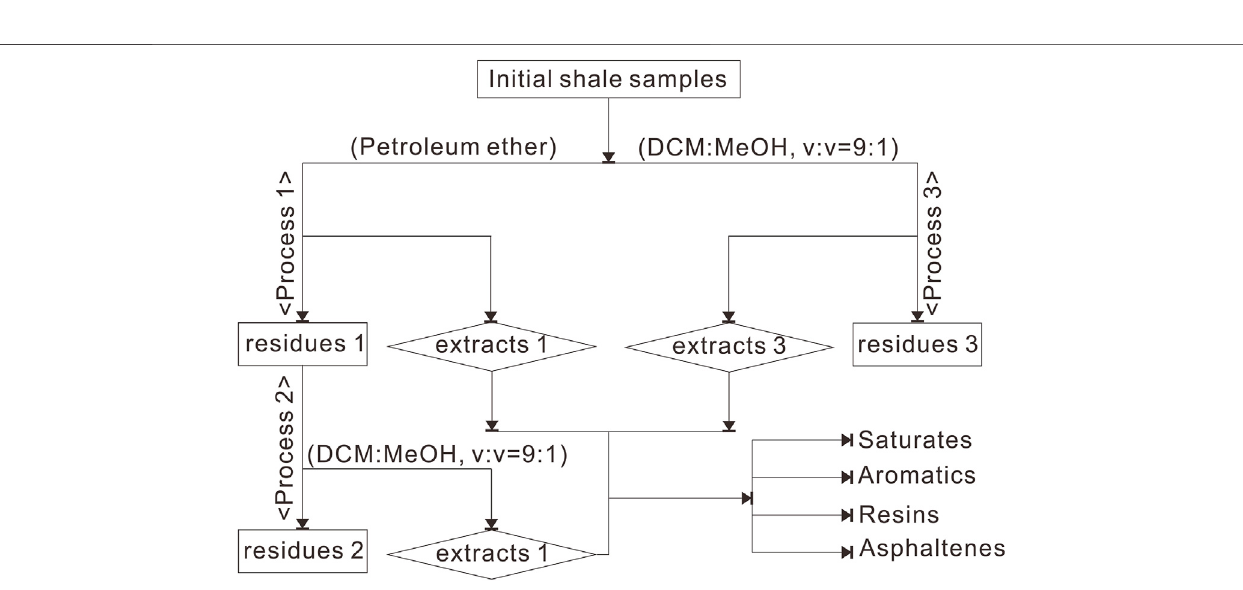
FIGURE 2 | Experimental procedure for sequential